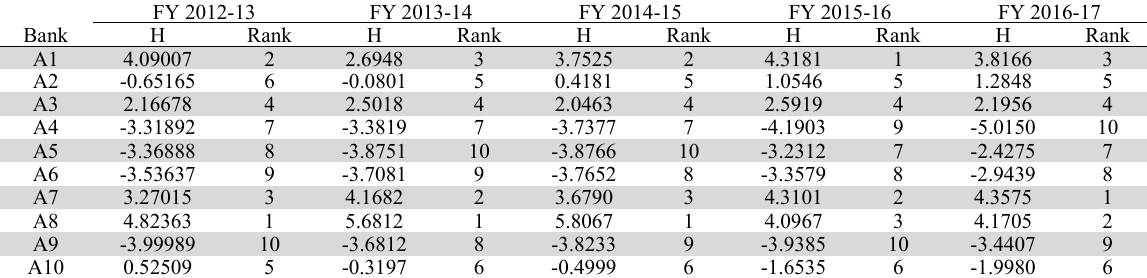
Year wise financial performance based ranking (CODAS method)